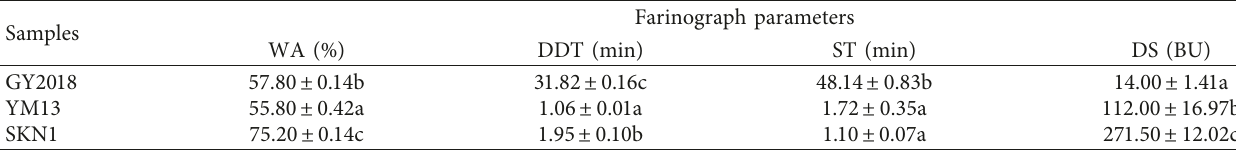
Figure 2: Analysis of wet gluten content (a) and gluten index (b) in GY2018, YM13, and SKN1. Significant distinctions between the different varieties are represented by different letters ( p < 0 . 05). Table 2: Rheological properties of GY2018, YM13, and